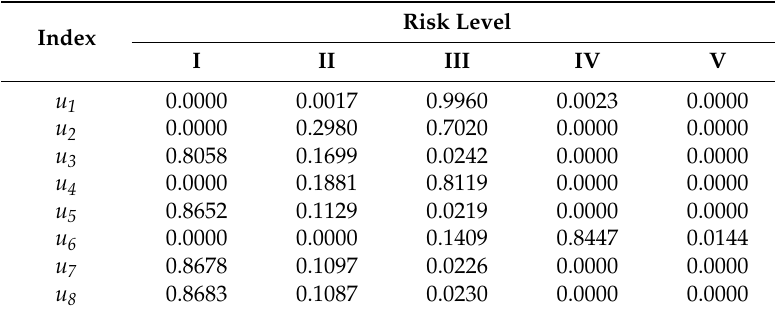
Table 16. Certainty degrees of AP of southeast